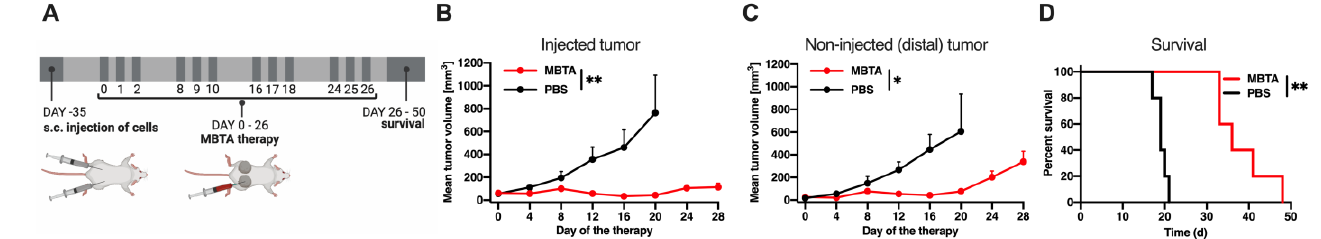
Figure 1. Bilateral subcutaneous PHEO mouse model. ( A ) Experimental design diagram of MBTA therapy in the bilateral subcutaneous PHEO mouse model. ( B ) The tumor volume growth of the injected and ( C ) the distal tumors presented as growth curves ( n = 5 per group) (* p < 0.05, ** p < 0.01). ( D ) The survival analysis presented as a Kaplan – Meier curve (** p < 0.01).